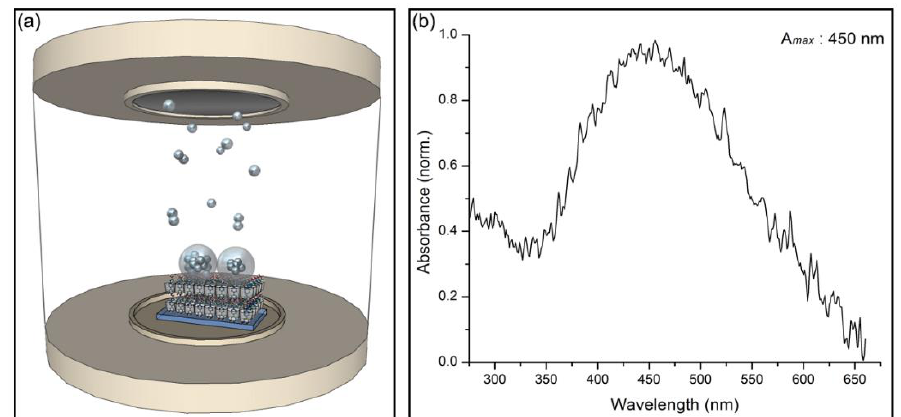
Figure 5. ( a ) Scheme of the release of atoms and formation of AgNPs on crystals of the βCD– Mel complex from the cathodic sputtering of a metal foil; ( b ) absorbance spectra of AgNPs deposited on βCD– Mel using magnetron sputtering.